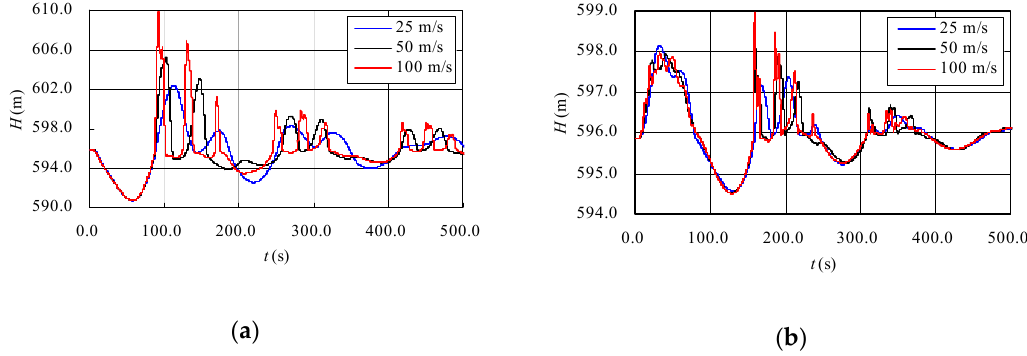
Figure 8. Time histories of the piezometric head at section A with different wave speeds: ( a ) computing case C1; ( b ) computing case C2.